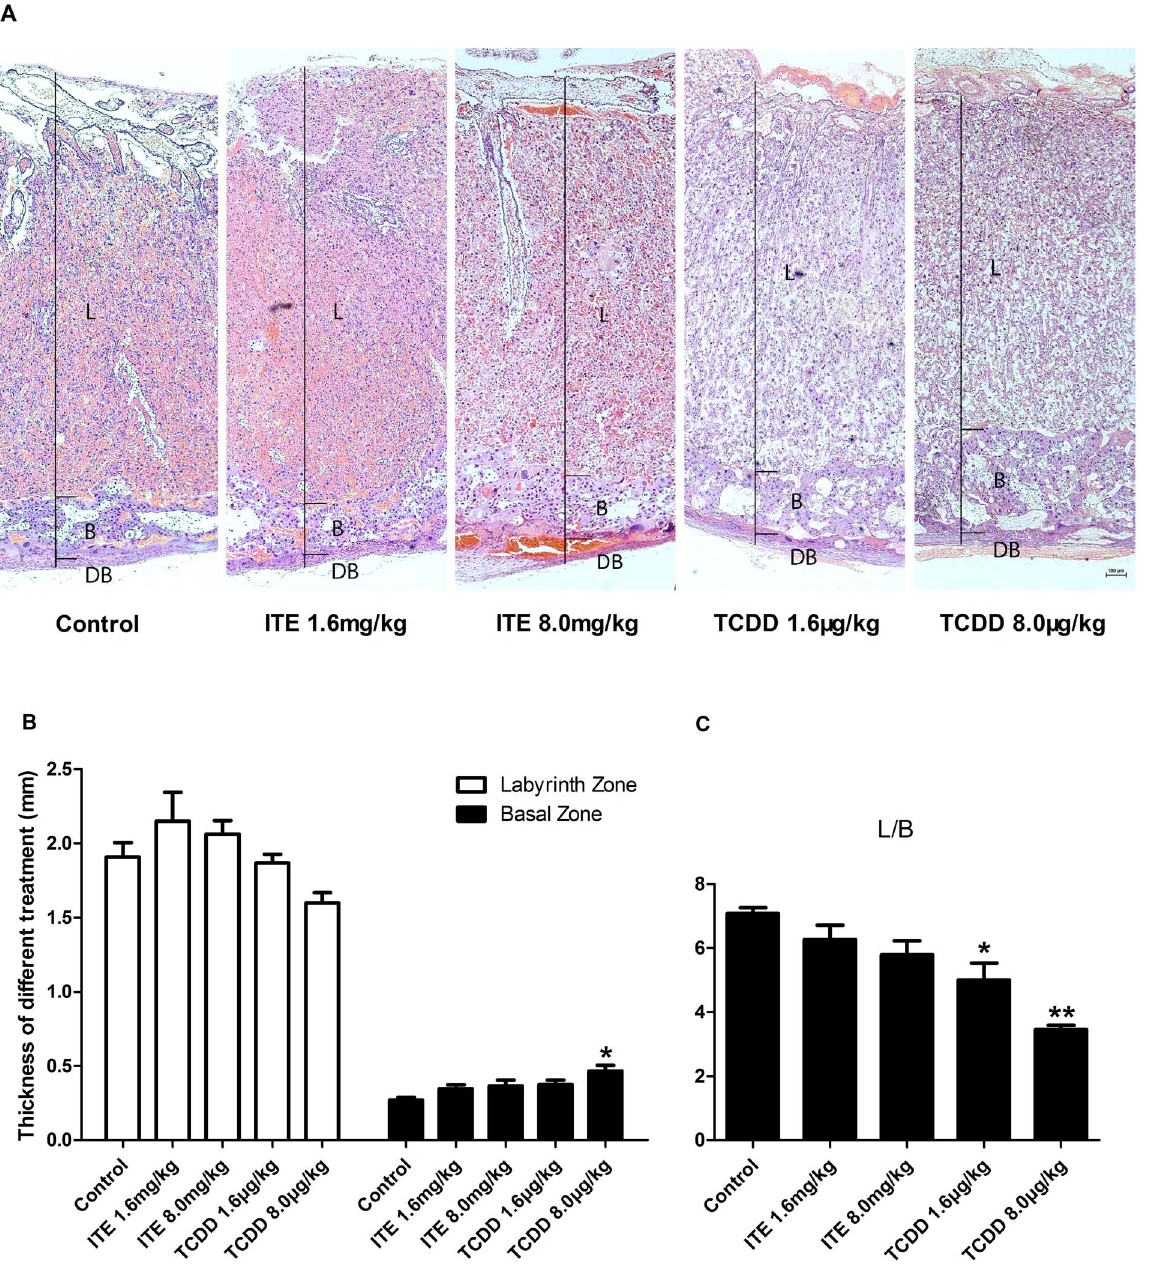
Figure 3. Effects of ITE and TCDD on placental morphology. A. HE staining for rat placentas (L, labyrinth zone; B, basal zone; DB, decidua basalis). Bar, 100 m m. B. Quantification of thickness of the labyrinth and the basal zone. C. Ratio of the labyrinth zone to the basal zone. *Differ from the control ( p , 0.050), **differ from the control ( p , 0.001; n=5/group). Data are expressed as means 6 S.E.M.